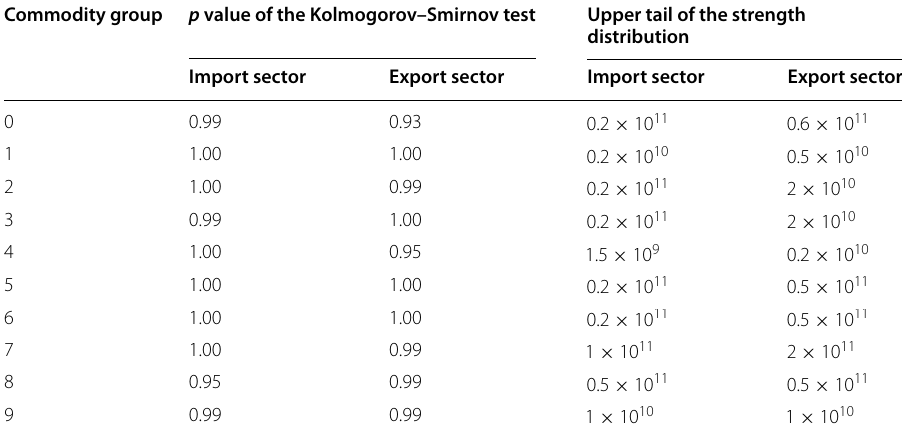
The first column lists the commodity groups. The second and third columns describe the p value of the Kolmogorov– Smirnov test in the import and export sectors, respectively. The fourth and fifth columns show the upper tail of the strength distribution in the import and export sectors,